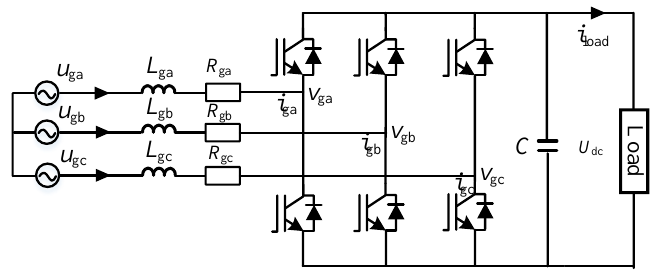
Figure 2. Main circuit of GSC.